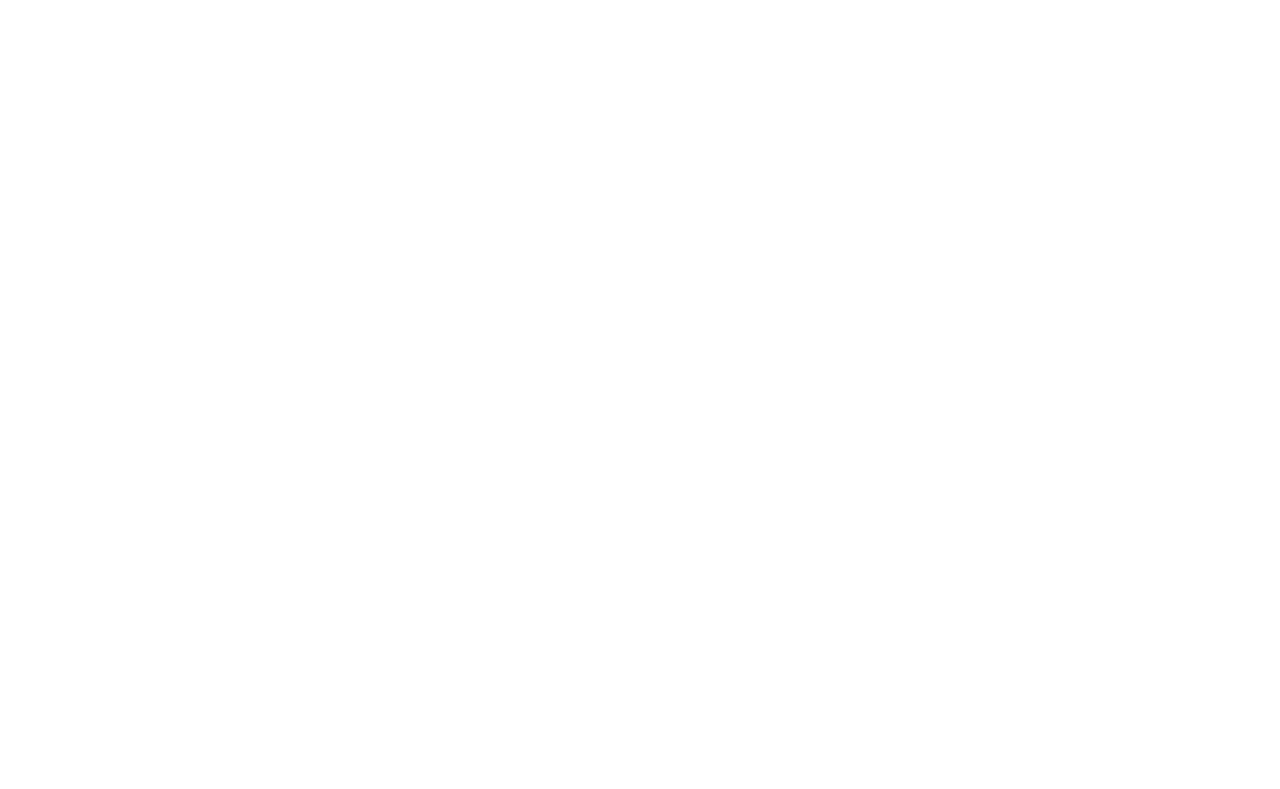
Frontiers in Plant Science | Plant